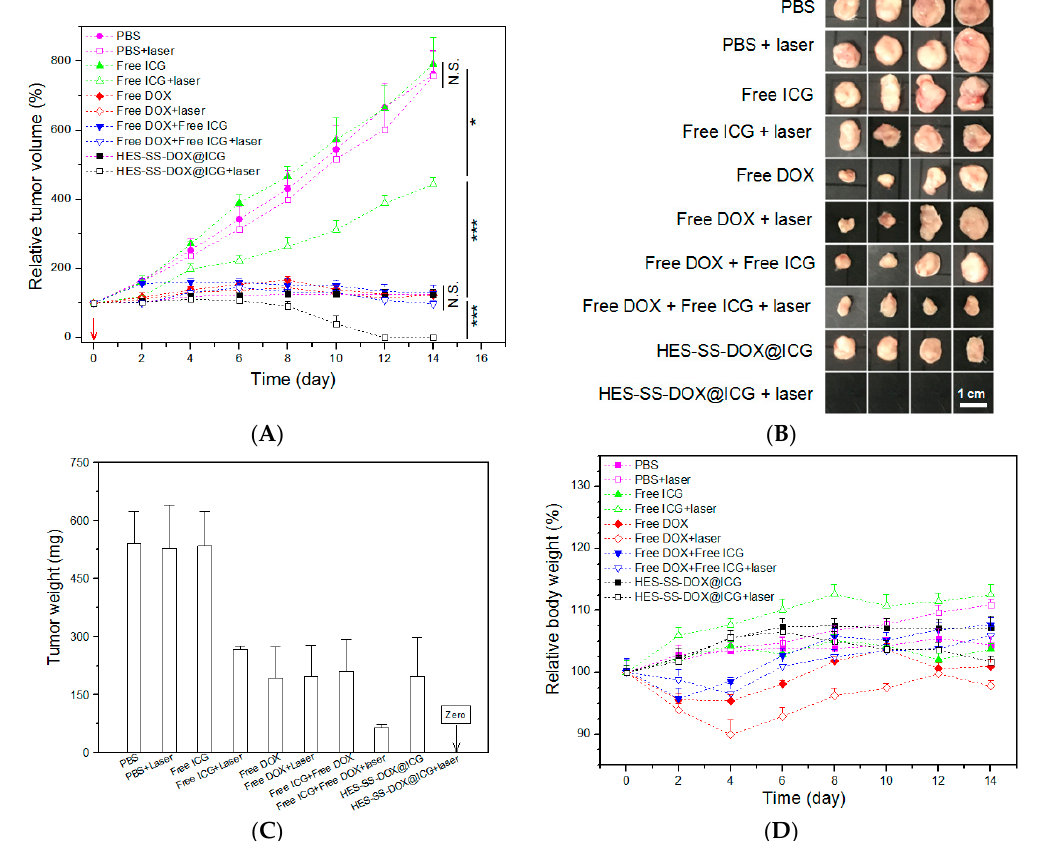
Figure 7. Time-dependent variations of tumor volume ( A ), images ( B ), and average weight ( C ) of tumors excised from mice after 14 days of treatment, and changes in body weight ( D ) for the treated mice (the inserted red arrow indicates the day for the injection, irradiation intensity, and time for all involved cases were 0.75 W/cm 2 and 5 min. The applied equivalent amount of DOX and ICG was 8 mg/kg and 3.4 mg/kg. N.S., no significance. * p < 0.05. *** p < 0.001. n =